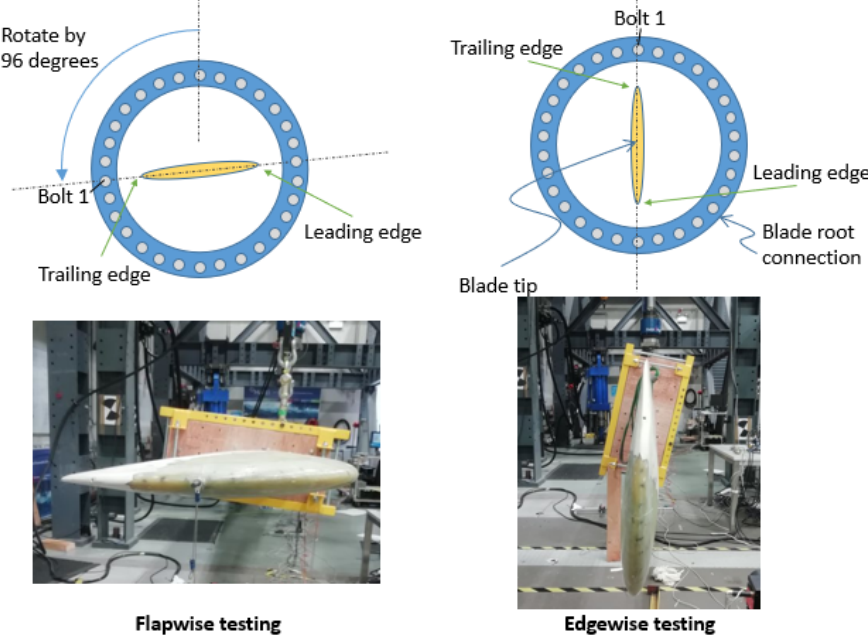
Figure 6. Orientation of the installed wind turbine blade during the static testing campaign.